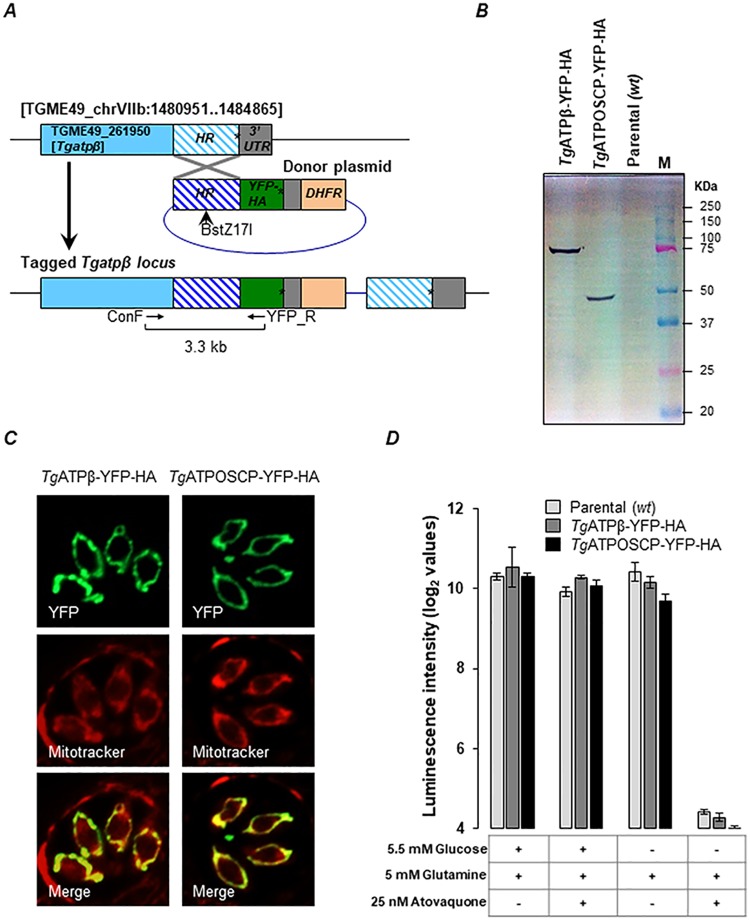
Endogenous tagging of Tgatpβ and Tgatposcp genes with YFP-HA tags.(A) Schematic representation of the Tgatpβ(TGME49_261950) gene locus showing coding region in light blue and 3′ UTR in gray. The hatched region shows the HR, which was cloned into a donor plasmid (dark blue) upstream of an in-frame coding region for YFP-HA tag. The donor plasmid also includes the DHFR cassette, which confers pyrimethamine resistance. Asterisk denotes the position of stop codon. The donor plasmid was linearized with the restriction enzyme BstZ17I to facilitate single-crossover homologous recombination, and the resulting modification of the gene locus was confirmed by PCR using the primers ConF and YFP_R. A similar strategy was used to tag the Tgatposcp gene locus. (B) and (C) Confirming the expression of the TgATPβ-YFP-HA and TgATPOSCP-YFP-HA proteins by SDS-PAGE western blotting (B) and microscopy (C) on respective clonal transgenic lines. Gel lanes in (B): 1, Cell lysate from TgATPβ-YFP-HA transgenic parasites; 2, Cell lysate from TgATPOSCP-YFP-HA transgenic parasites; 3, Cell lysate from parental parasites; M, Molecular weight size markers. Mitotracker was used to visualize the mitochondrion in (C). (D) Functional validation of mitochondrial ATP synthesis in wt parental strain, and TgATPβ-YFP-HA- and TgATPOSCP-YFP-HA-expressing transgenic parasites. All three strains exhibited similar response to atovaquone treatment in the presence and absence of glucose, thereby confirming that the YFP-HA tag had no effect on mitochondrial ATP synthesis. The raw luminescence reading from this experiment and its analysis are provided in S1 Data file. DHFR, dihydrofolate reductase; HR, homology region; TgATPβ, T. gondii ATP synthase β subunit; TgATPOSCP, T. gondii ATP synthase OSCP subunit; wt, wild type; YFP-HA, yellow fluorescent protein plus hemagglutinin.